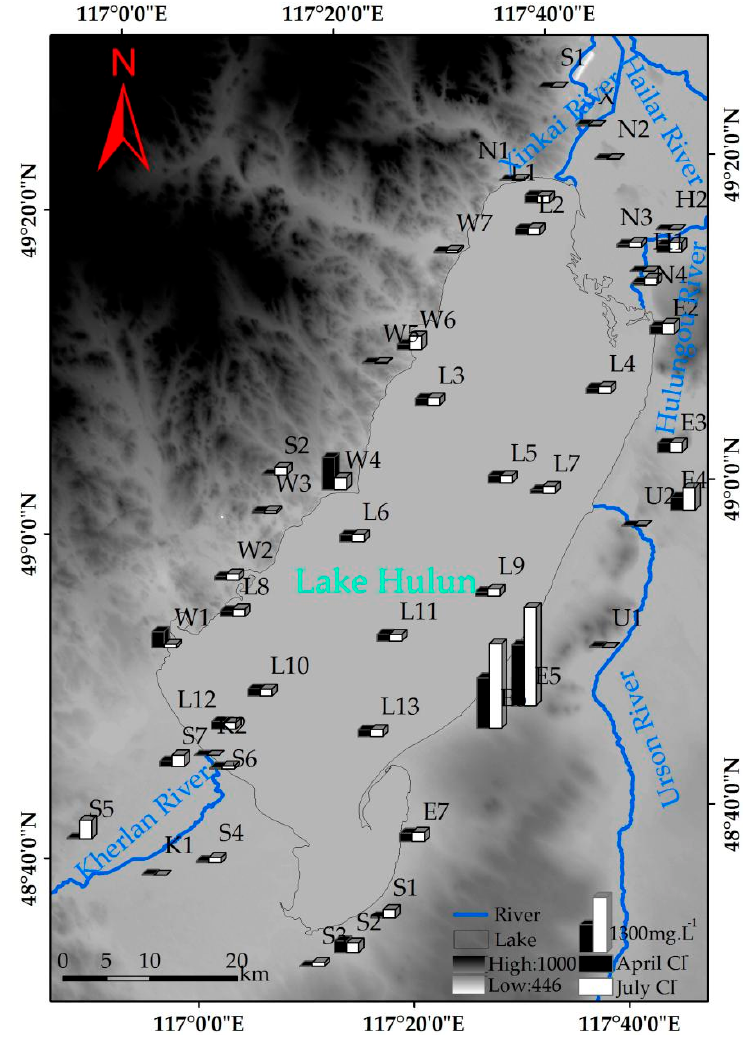
Figure 5. Distribution of Cl − concentrations in water bodies in the Lake Hulun area during frozen and non-frozen periods.